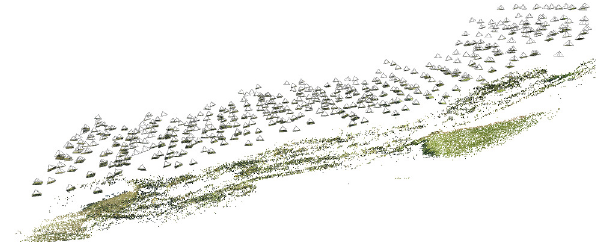
Figure 8. Sparse reconstruction result of Set2 showing the sparse point cloud and the camera poses. Figure 11. Color coded 3D result of Set2: The objects are color coded by their semantics according to Table 3. The dense reconstruction has been rasterized using a voxel size of 2 m.